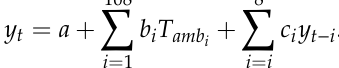
Figure 9. Prediction mechanisms.